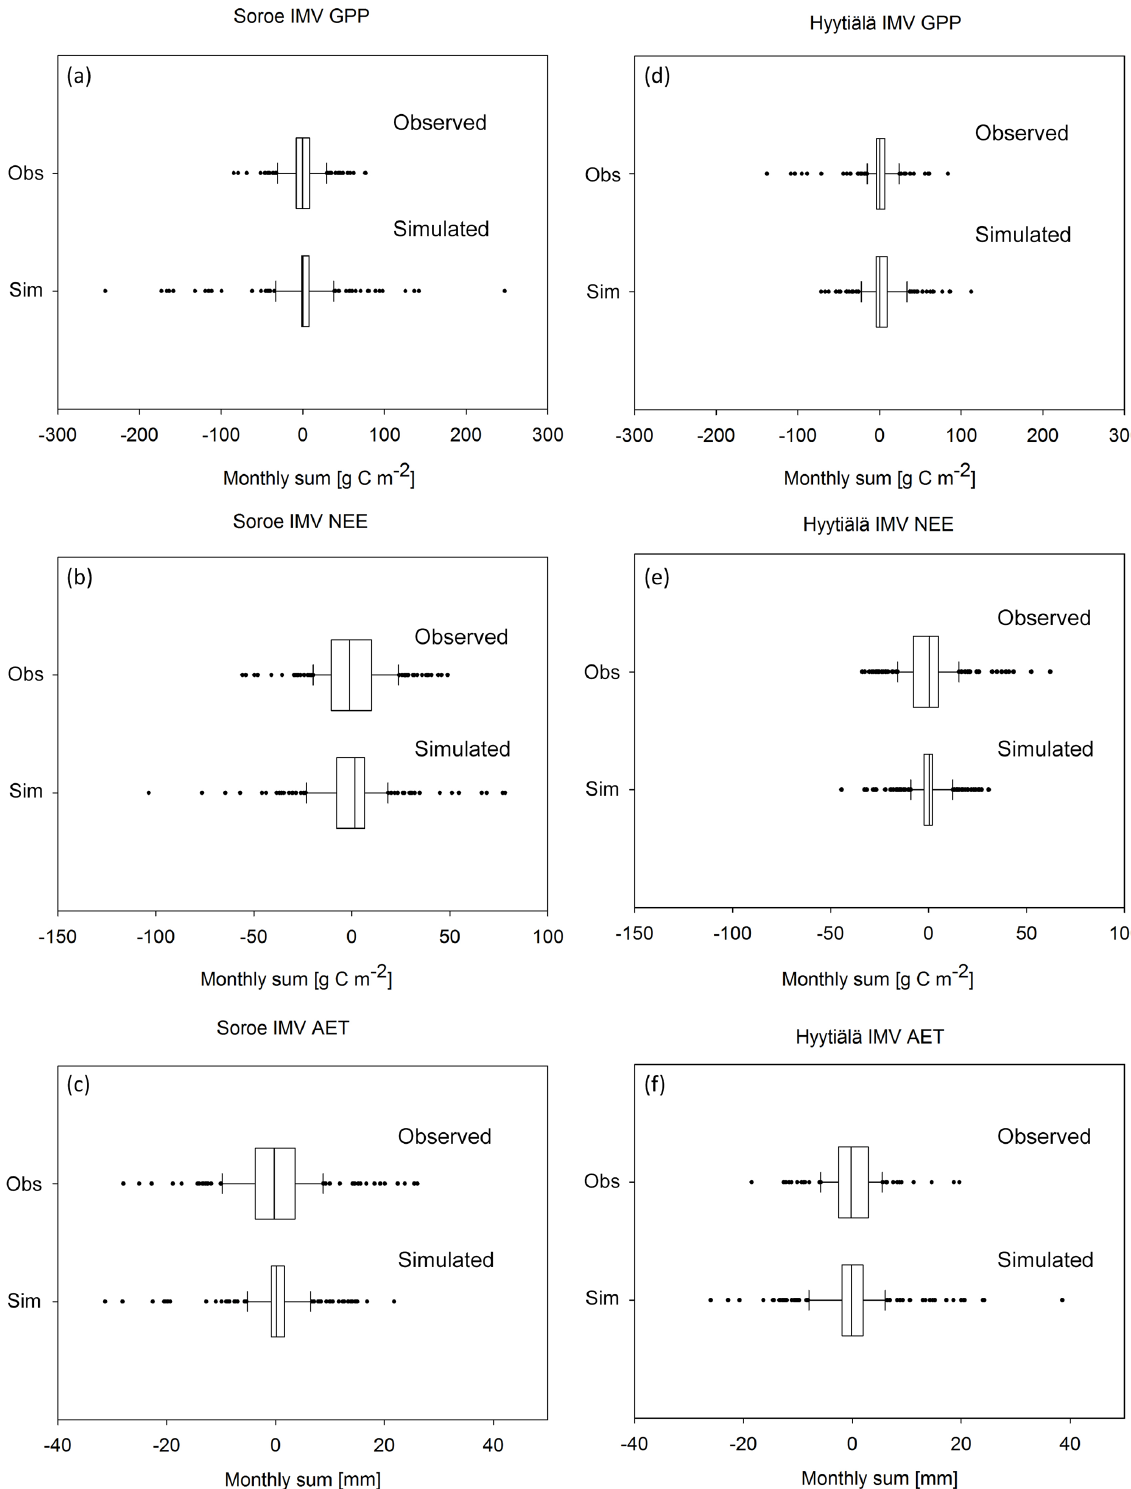
Figure 8. Distribution of the magnitude for the inter-monthly variability values (IMV) of observed (obs, in upper part of the graphic) and simulated (sim, in the lower part of the graphic) monthly sums of GPP, NEE, and AET in Sorø (a–c) and Hyytiälä (d–f) . The graphs show the median, the 25th and 75th percentile (box), the 10th and 90th percentile (whiskers), and outliers (black dots).